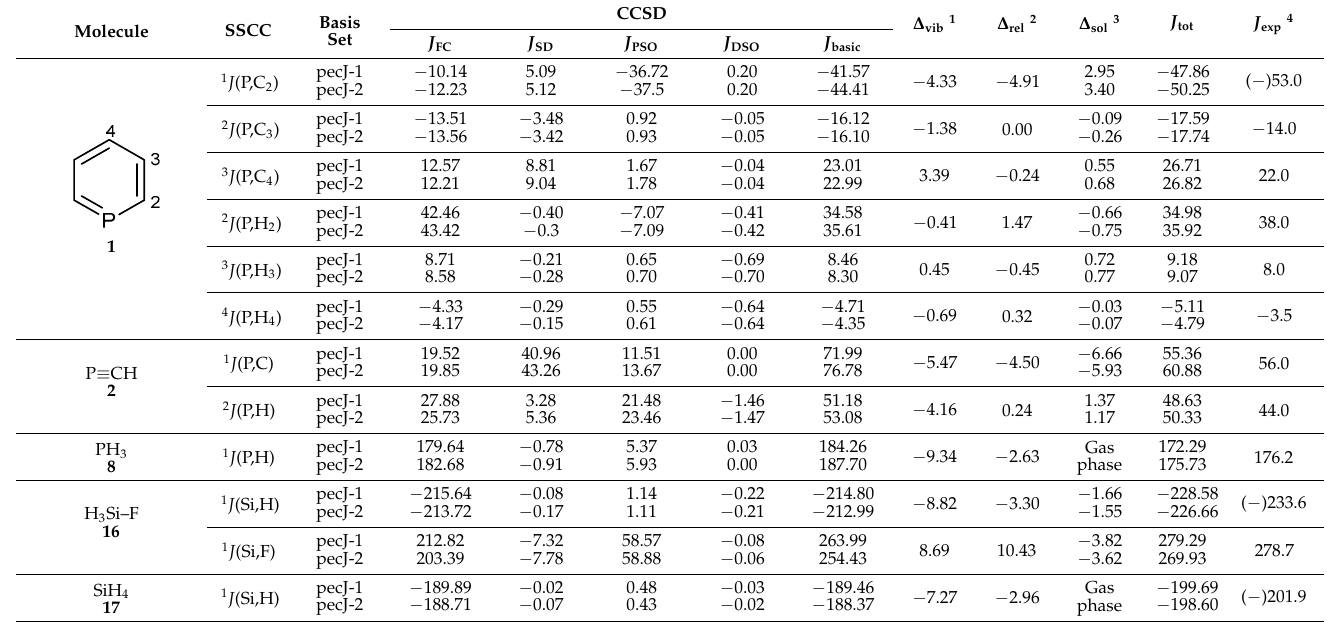
Table 5. Comparison of the theoretical SSCCs calculated with the pecJ-1 and pecJ-2 basis sets with the experimental data (in Hz).